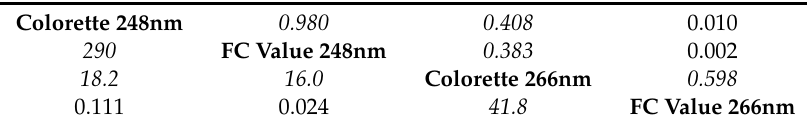
Table 4. Correlation matrix of target projection (TP) loadings with Pearson’s r in upper and − log 10 (p) in the lower triangular part of the matrix. Significant correlations ( α = 0.05, − log 10 (p) > 1.301) are indicated in italic.